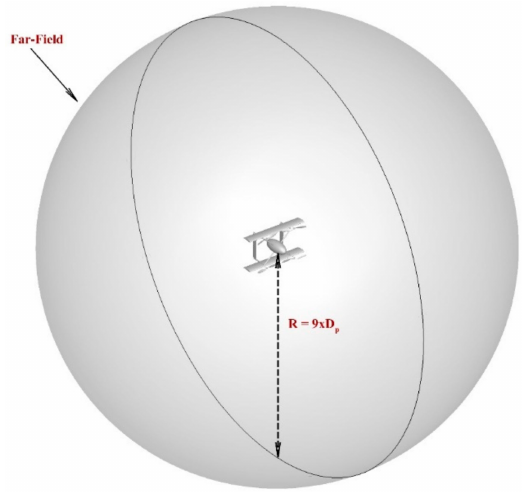
Figure 3. Computational domain for CRC-3 simulations.